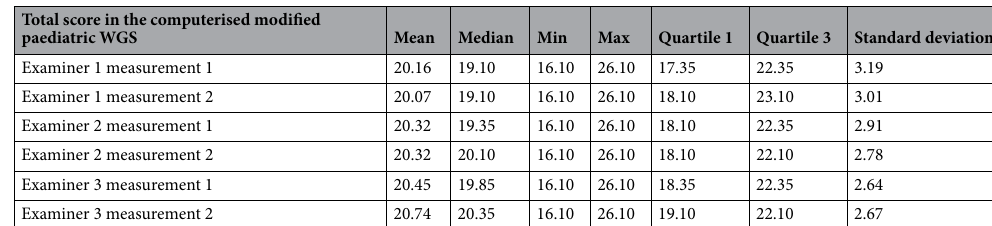
Table 3. Descriptive statistics for the computerized paediatric